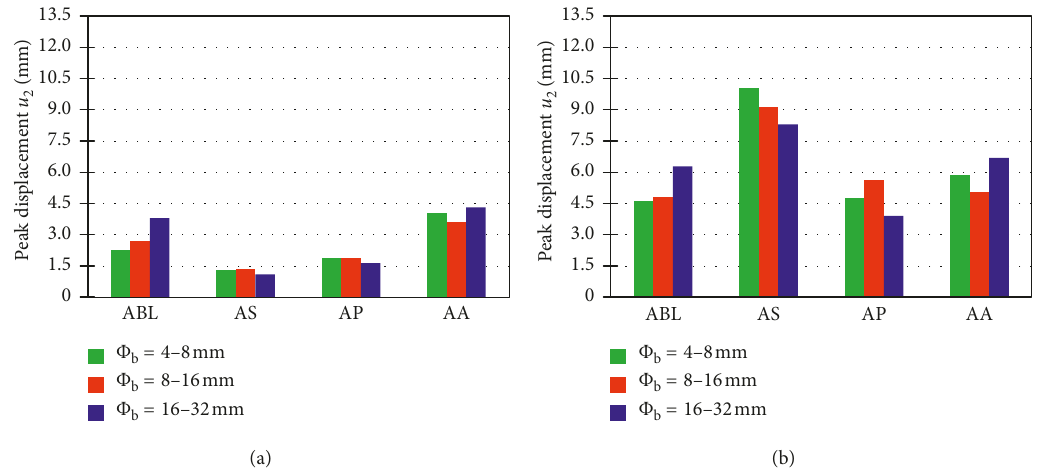
Figure 15: The effect of pebble fraction on peak horizontal displacement u